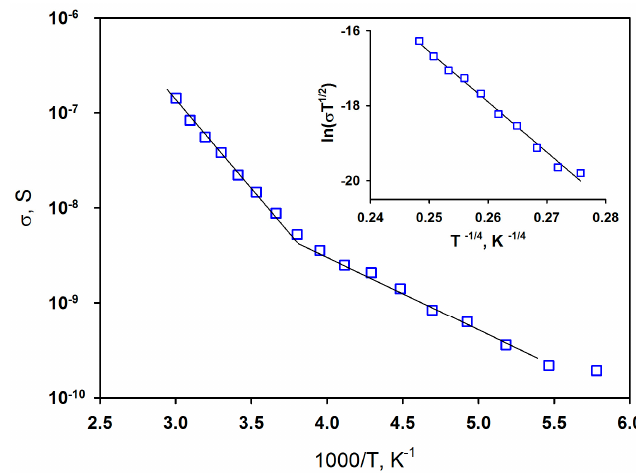
Figure 6. Temperature dependence of the conductivity of nanocrystalline Co 3 O 4 thick film. Inset: temperature dependence of the conductivity in the Mott VRH model coordinates.